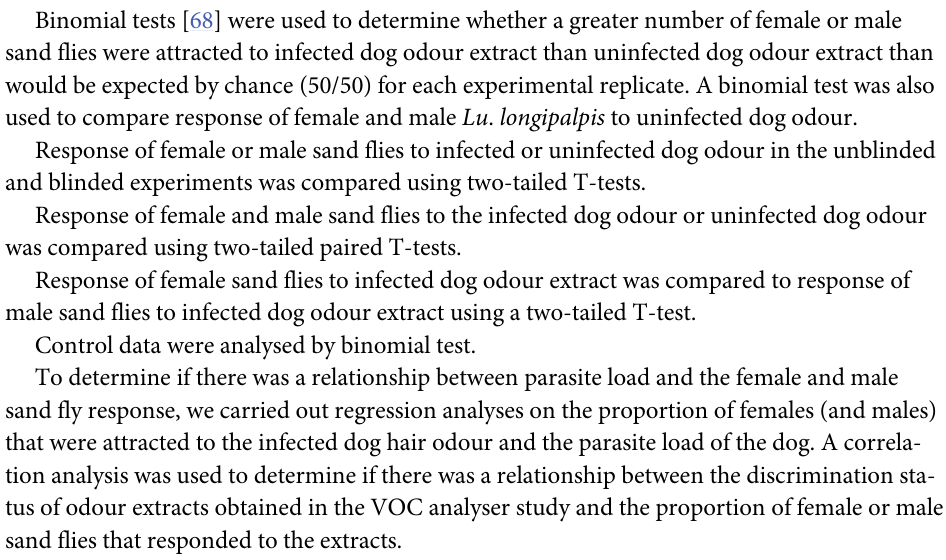
S1 Table. Female Lutzomyia longipalpis response to entrained odour of infected and unin- fected dogs in unblinded and blinded Y-tube olfactometer experiments. Summary of blinded and unblinded Y-tube bioassay experiments for female Lu . longipalpis . The odour extracts from infected dogs (in bold) and uninfected dogs are shown. Infected = the number of male sand flies attracted to the arm of the Y-tube containing infected odour; uninfected = the number of male sand flies attracted to the arm of the Y-tube containing uninfected odour; no-